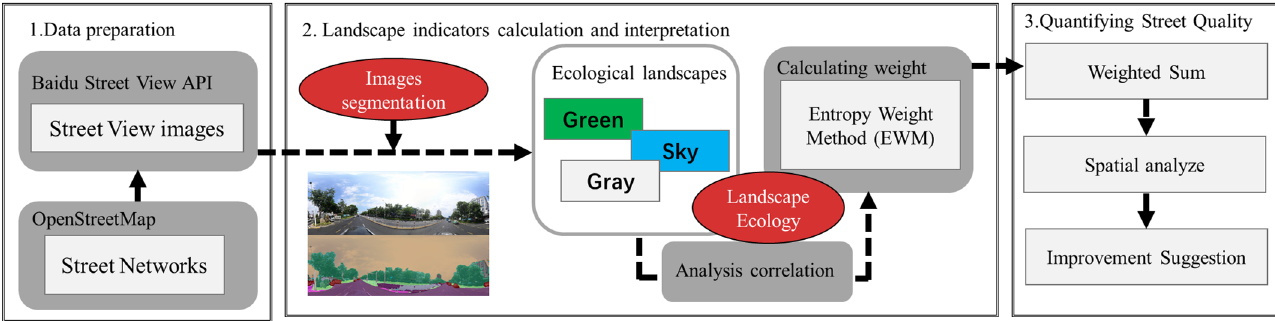
Figure 1. The workflow in this study.